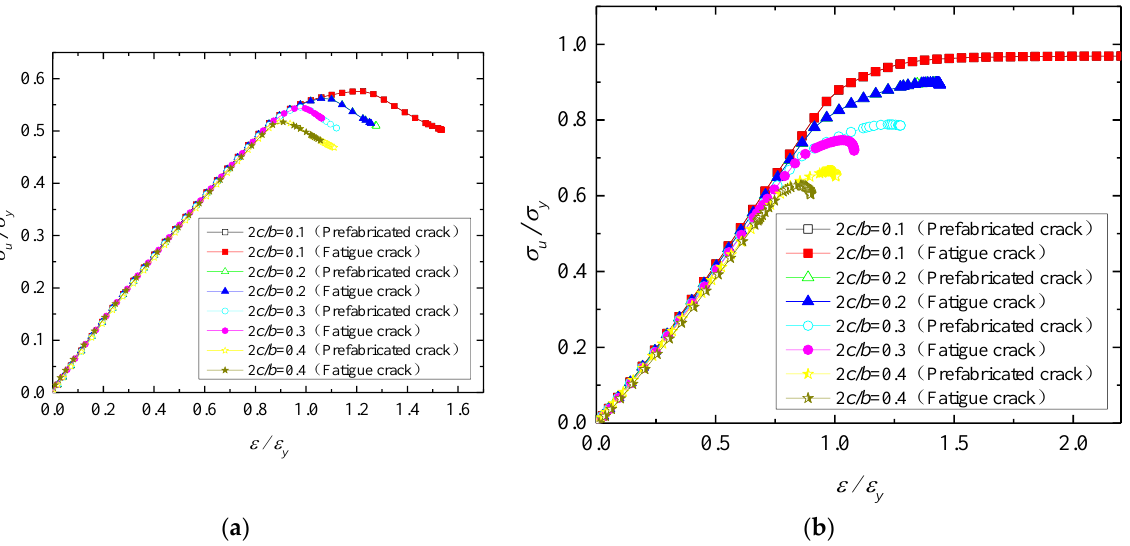
Figure 18. Load displacement curves at different crack lengths: ( a ) compressive load; ( b ) tensile load. Figure 19a,b show the relationship between relative crack length and residual strength.